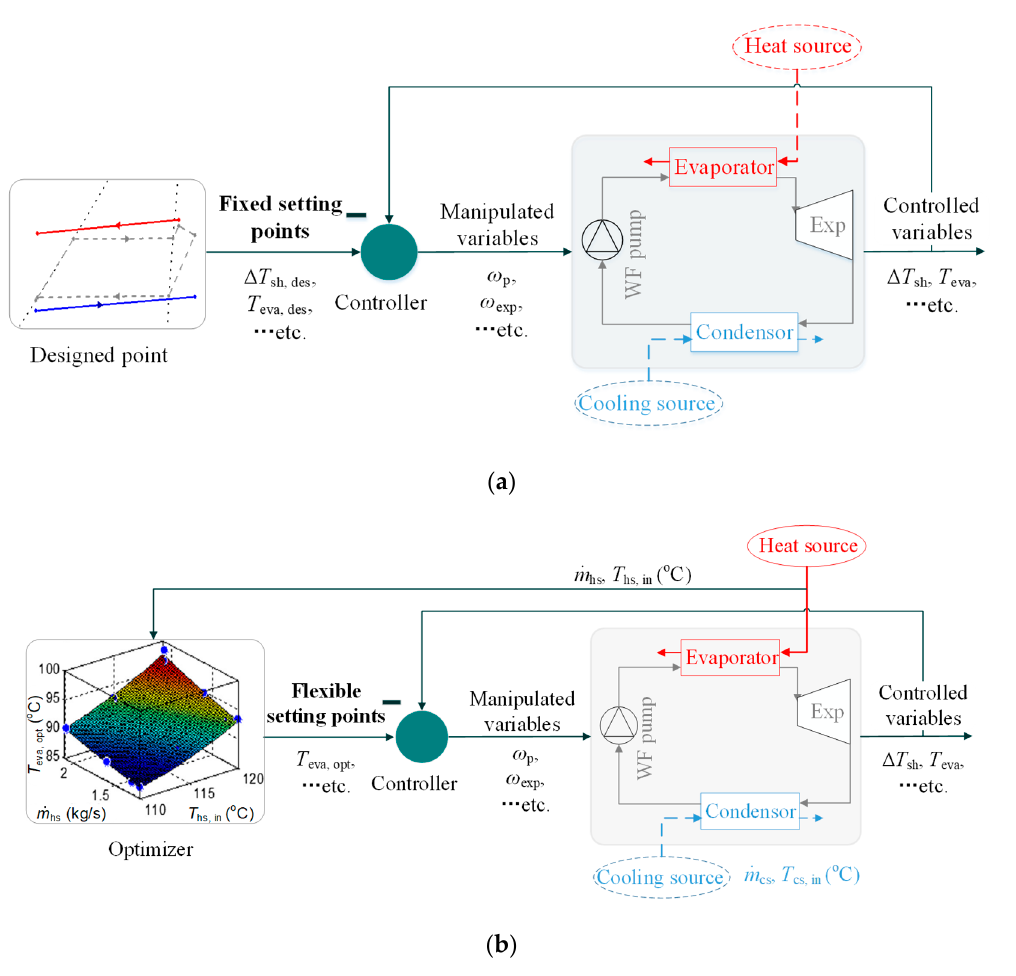
Figure 1. State-of-the-art ORC operation and control strategies: ( a ) conventional strategy; ( b ) ad- vanced strategy [12].